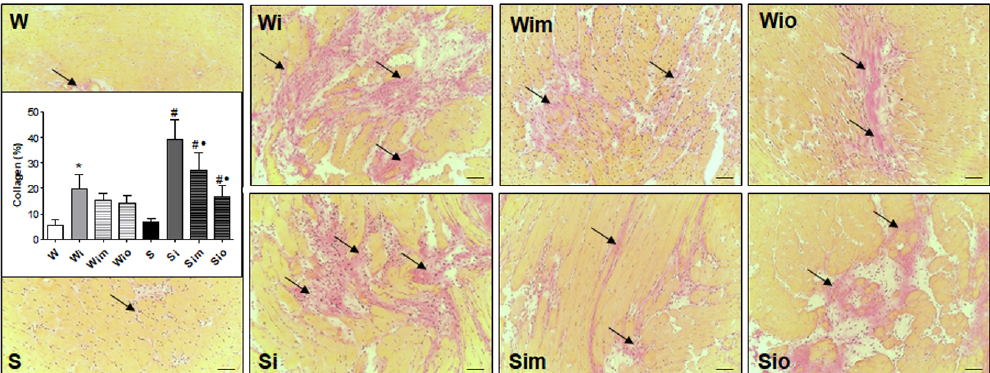
Figure 7. Van Gieson staining demonstrated abnormal collagen deposition (arrows) and a significant control rat hearts (W, S). The treatment with melatonin (Wim, Sim) and omega-3 (Wio, Sio) suppressed